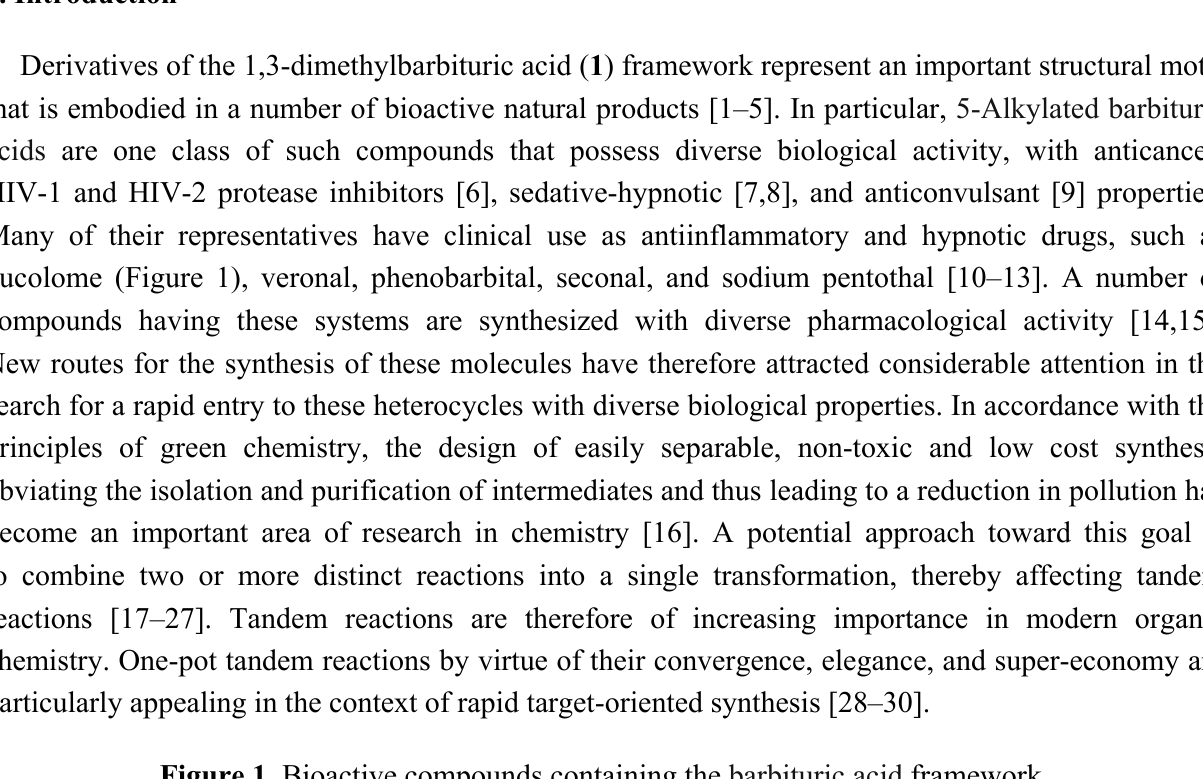
Figure 1. Bioactive compounds containing the barbituric acid